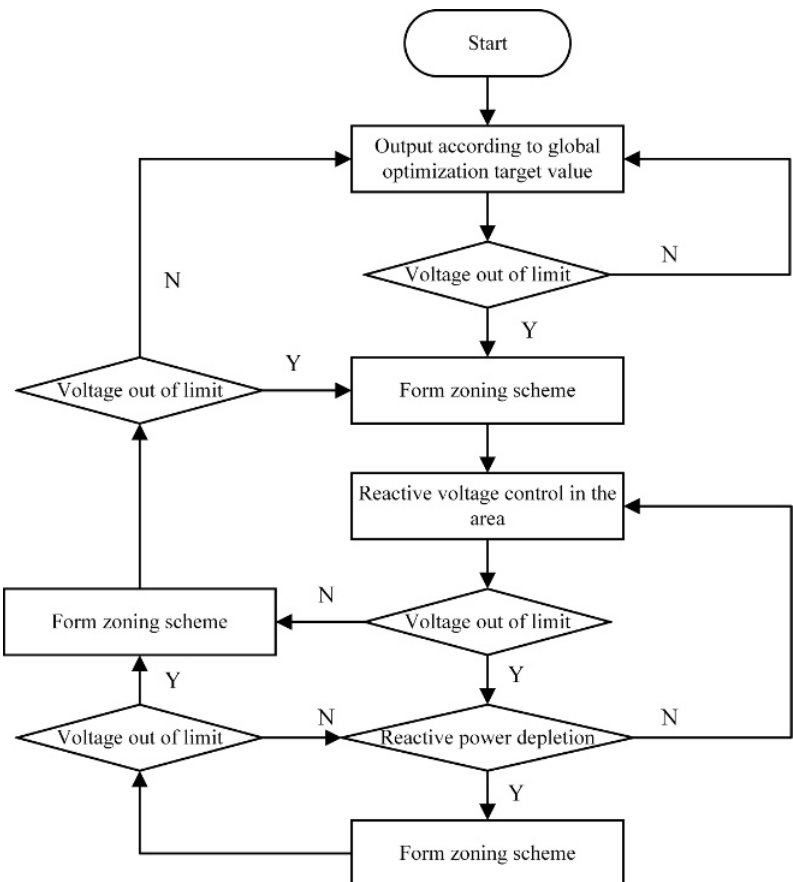
Fig. 3. Flow chart of real-time control over voltage